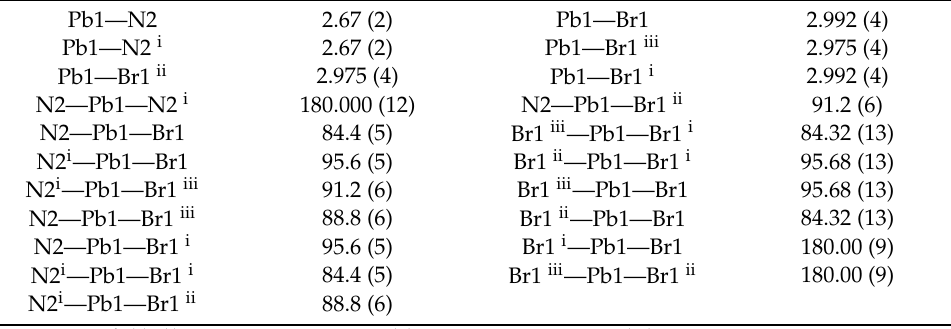
Table 2. Selected bond lengths (Å) and angles ( ◦ ) for [Pb(L)Br 2 ] n ( 1